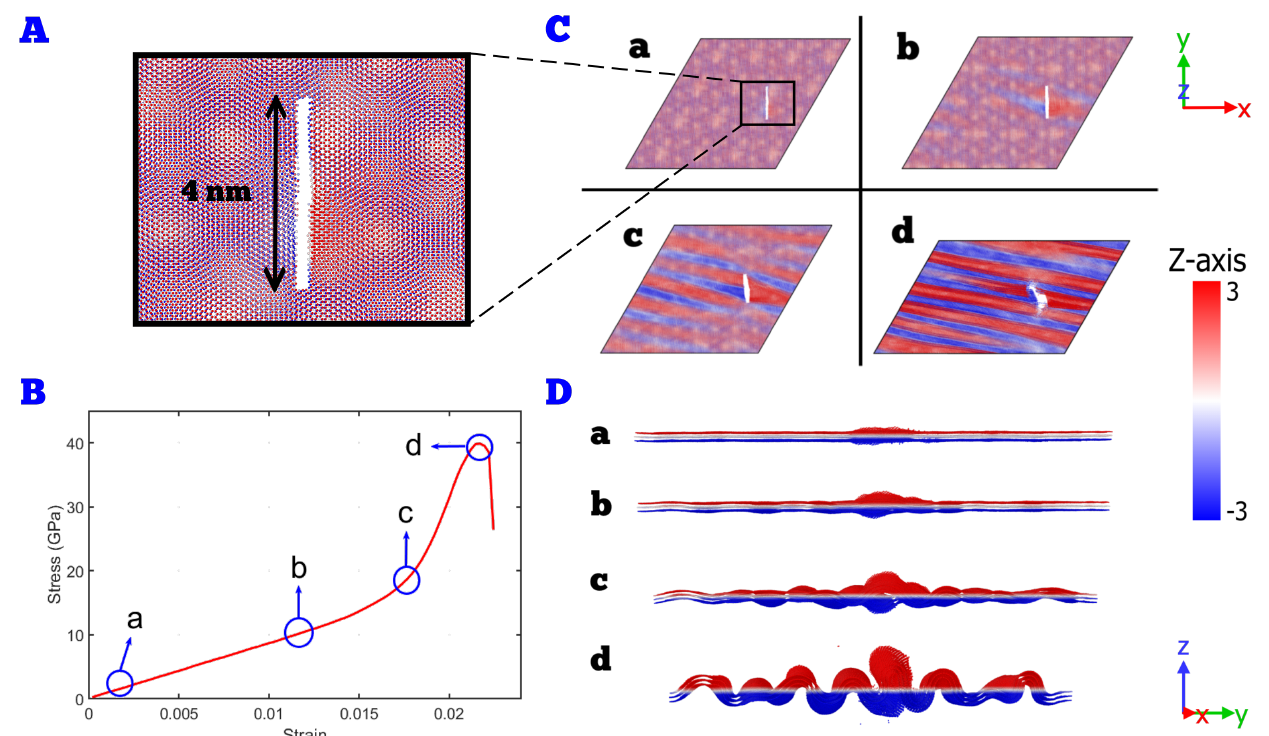
Figure 9. Fracture mechanics of brittle fracture in twisted trilayer graphene with a pre-crack: ( A ) structure of 4 nm pre-crack tTLG; ( B ) stress-strain response of 4 nm pre-crack tTLG; ( C ) top-down view of the fracture at different stages; ( D ) side view of the fracture at different stages; During the tensile, we have four snapshots of the selected 4 stage: ( a ) strain = 0; ( b ) strain = 0.012; ( c ) strain = 0.017; ( d ) strain = 0.022. The tensile simulation is under the following conditions: temperature